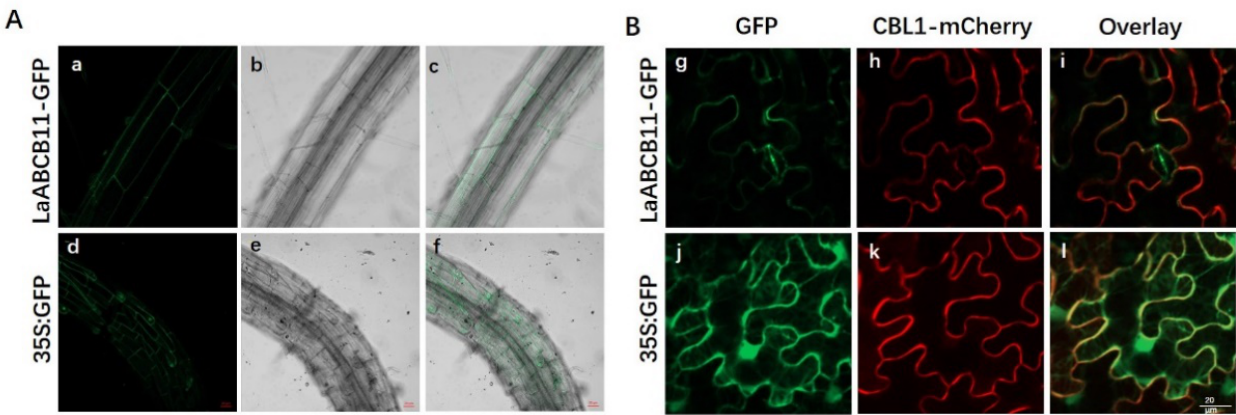
Figure 3. LaABCB11 localization in the cell. ( A ) Sub-cellular localization of LaABCB11-GFP in transgenic Arabidopsis root cells: ( a ) a root cell expressed LaABCB11-GFP (green); ( b ) the same cell in bright field; ( c ) merged images of ( a , b ); ( d – f ) GFP vector-expressing cells. Bars = 20 µm. ( B ) N. benthamiana leaf epidermal cells were transformed with the indicated plasmid combinations. Individual panels show: ( g ) an epidermal cell expressing LaABCB11-GFP (green); ( h ) the same cell expressing plasma membrane marker CBL1- mCherry (red); ( i ) merged images of ( g , h ); ( j – l ) GFP vector co-expressed with CBL1-mcherry. Bar = 20 um.